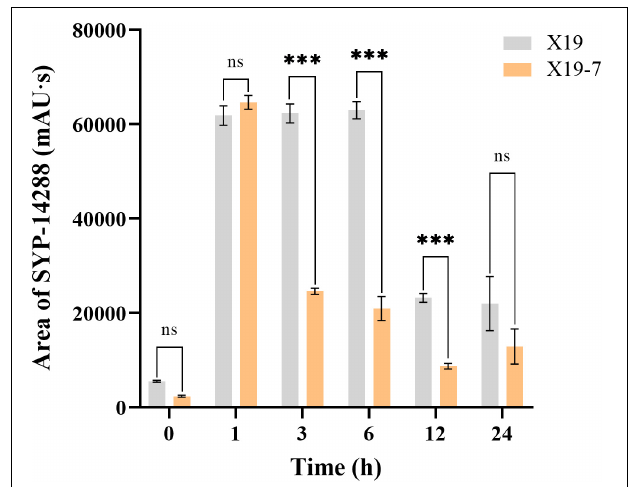
FIGURE 1 | Content of SYP-14288 in mycelia of Rhizoctonia solani wild-type strain X19 and SYP-14288-resistant mutant X19-7, which were treated with 0.005 and 0.1 µ g/ml SYP-14288, respectively. SYP-14288 was quantified at 0, 1, 3, 6, 12, and 24 h after treatment in high-performance liquid chromatography equipment. Values are mean ± SD of at least three independent experiments, and data were analyzed with ANOVA followed by Fisher’s least significant difference (LSD) test ( ∗∗∗ p < 0.01; ns,